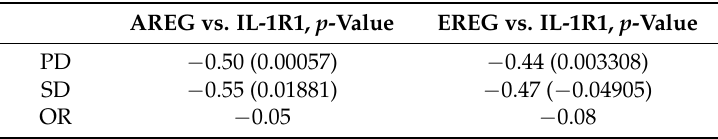
Table 1. Pearson correlation of IL-1R1 to AREG and